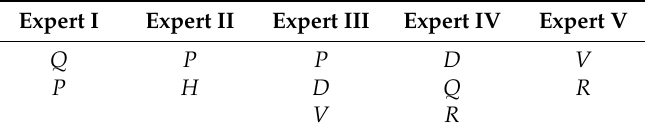
Table 3. Dummy dataset divided into segments.